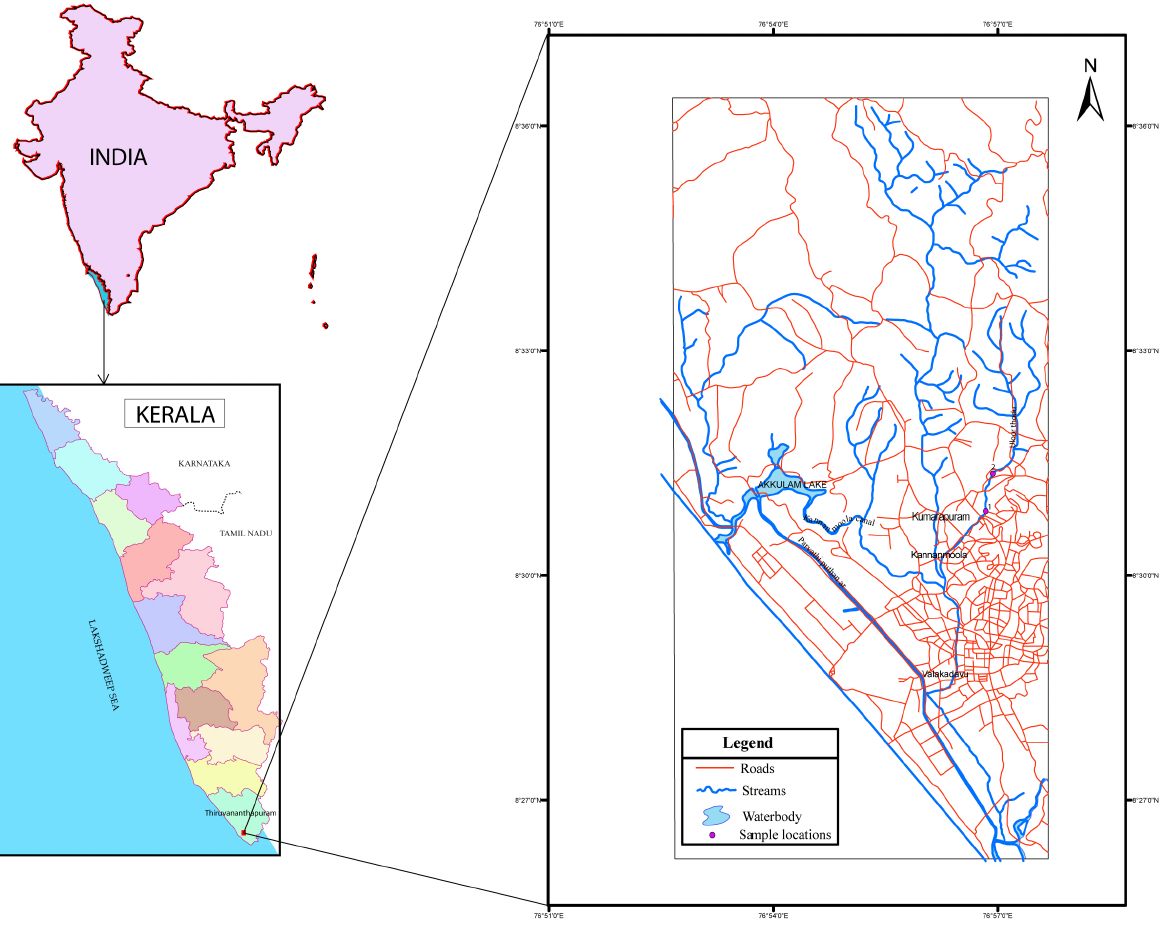
Figure 1. Drainages of Thiruvananthapuram City, Kerala showing collection sites